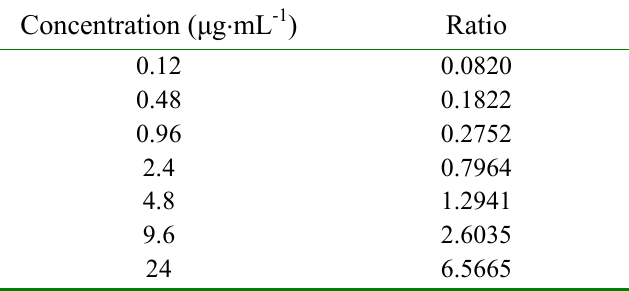
Table 3. Caffeine Calibration Curve Data.